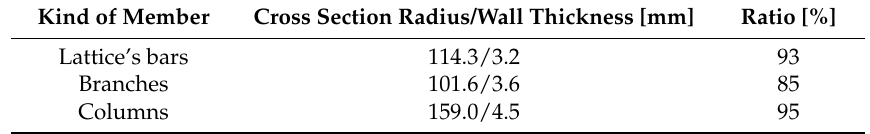
Table 3. Dimensioning of the considered conoid roof structures due to structural optimization.